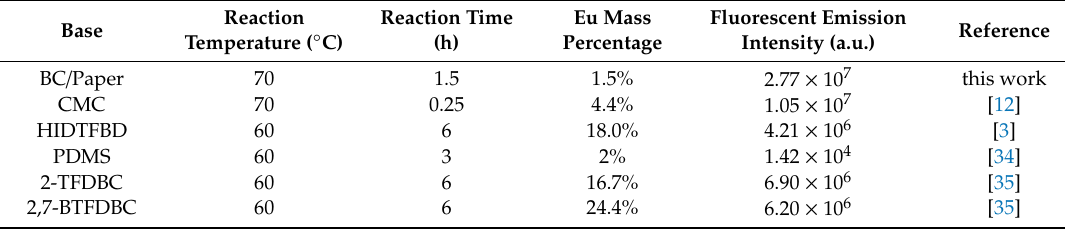
Table 2. Comparison of composites with di ff erent substrate loadings of Eu 3 +